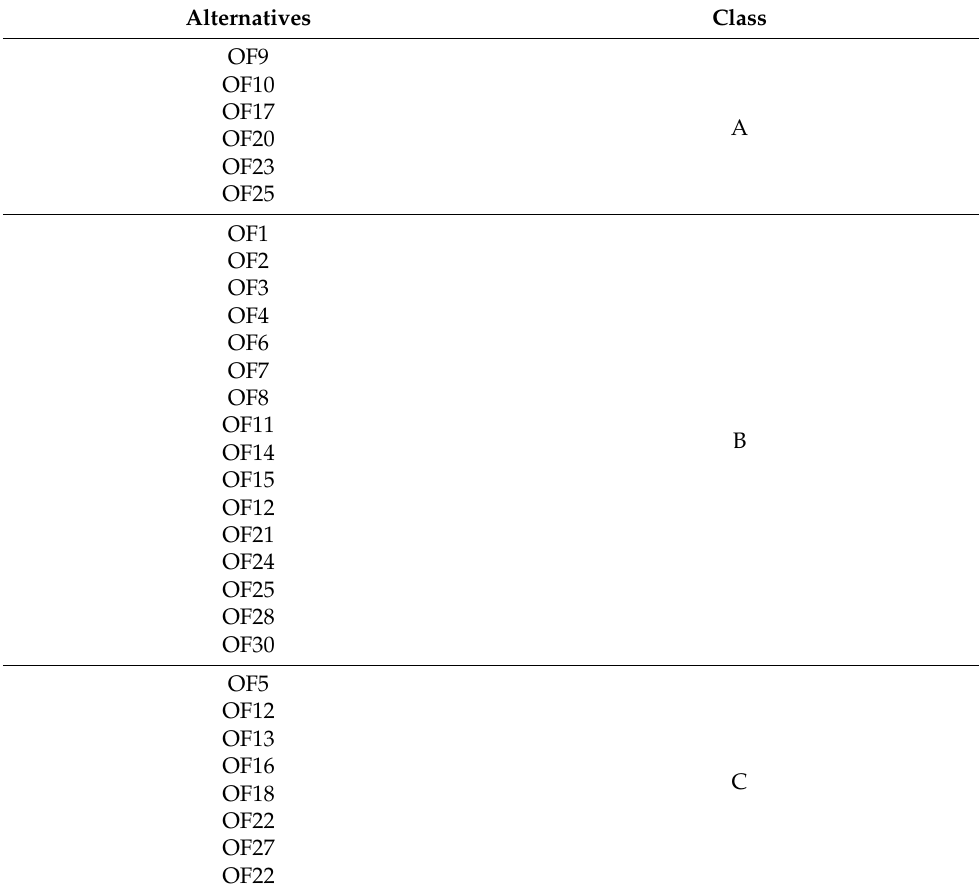
Table 12. Consolidated classification of alternatives, with a cut-off level of